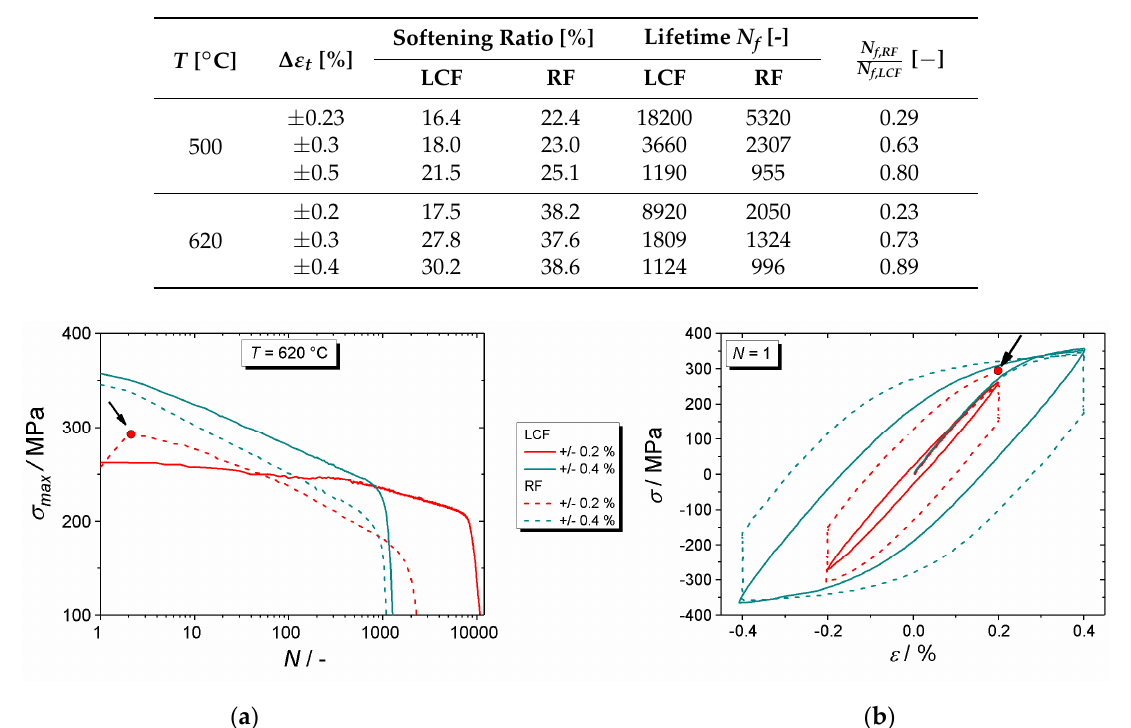
Table 8. Softening ratio, lifetime, and lifetime ratio for different LCF- and RF-tests.